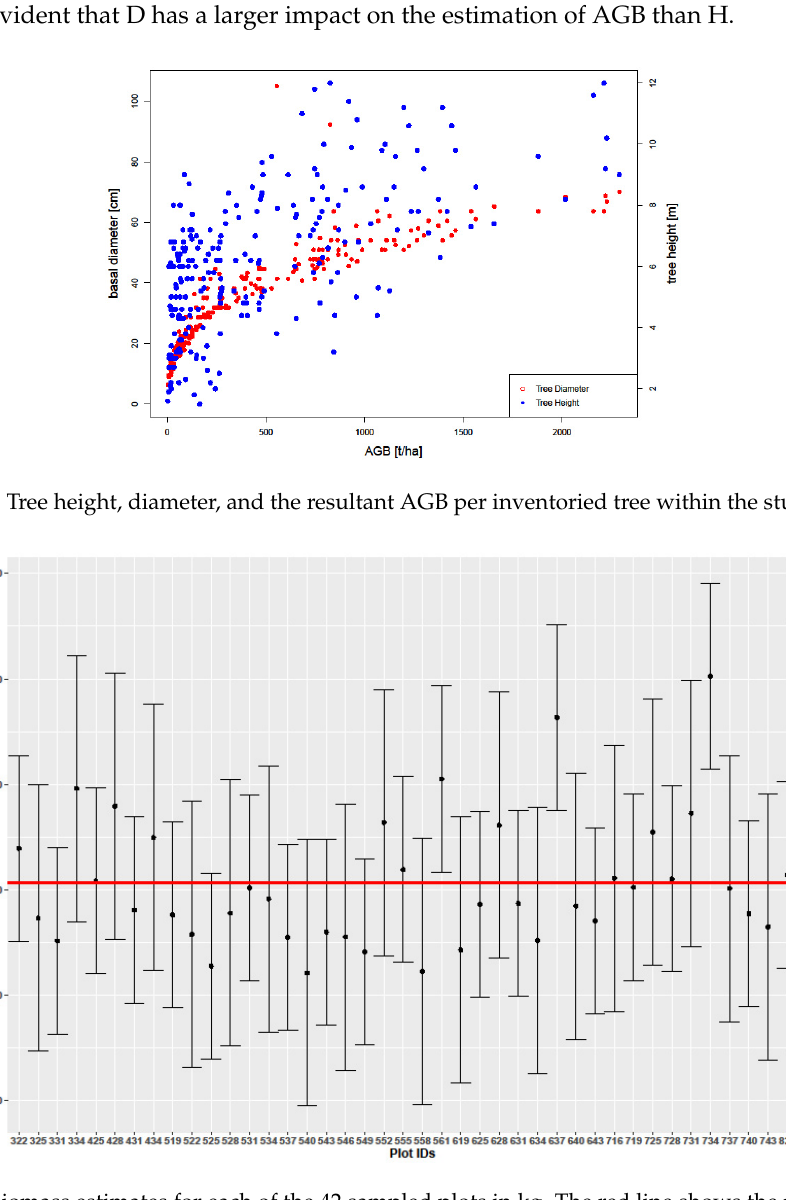
Figure 8. Biomass estimates for each of the 42 sampled plots in kg. The red line shows the mean AGB in kg while the bars are 95% confidence intervals for AGB. Each plot is 0.09 ha in size.